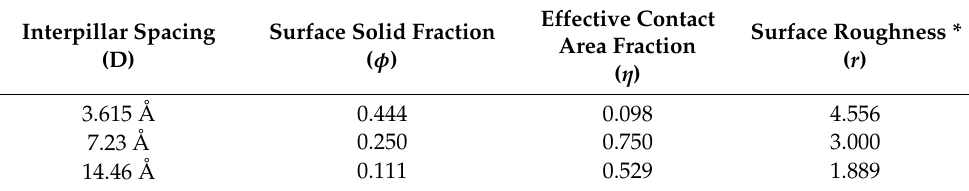
Table 2. The surface solid fraction, the effective contact area fraction and the surface roughness of nanopillar surfaces with different interpillar